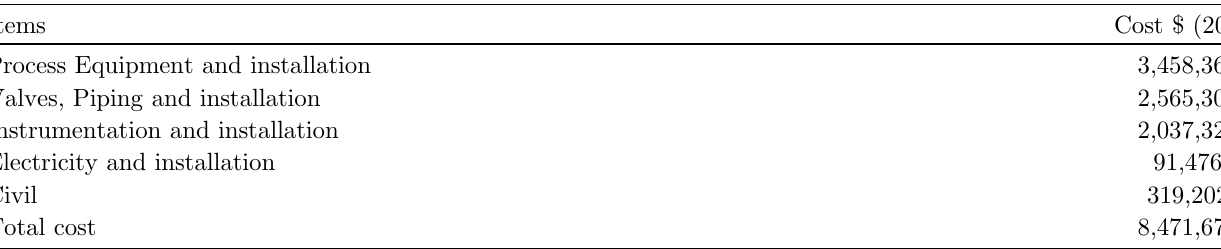
Table 6. Capital investments for each dew point control unit